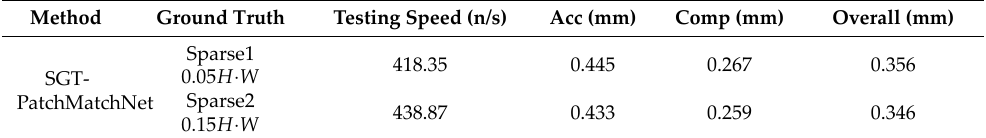
Table 3. Comparison table of the impact of different dense sparse points on network performance.